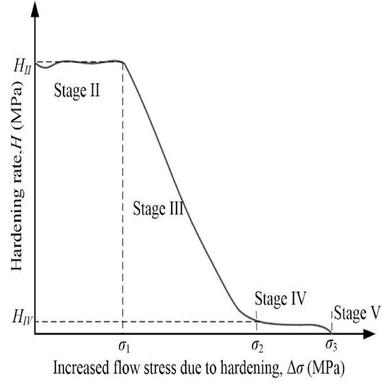
Schematic diagram of general hardening rate curve for polycrystalline materials. The vertical dashed lines indicate the boundaries of Stages III, IV and V, while σ1, σ2 and σ3 are the corresponding critical values of the increased flow stress due to hardening. The horizontal dashed lines indicate the hardening rates in Stages II and IV, while HII and HIV are the average values of hardening rate in the corresponding stages.